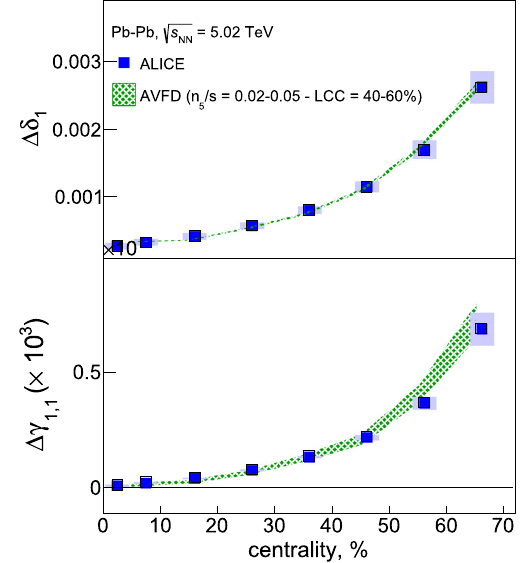
Fig. 9 The centrality dependence of (cid:9)δ 1 and (cid:9)γ 1 , 1 in the upper and lower panels, respectively. The data points represent the experimental band shows the results obtained from the tuned AVFD sample (see text for details)